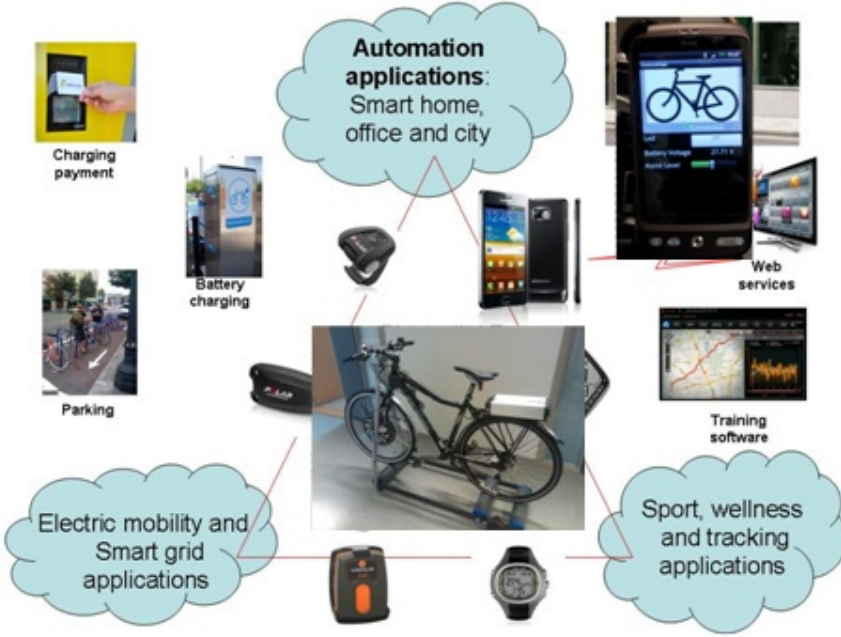
Figure 23. Electric Bike Ecosystem.